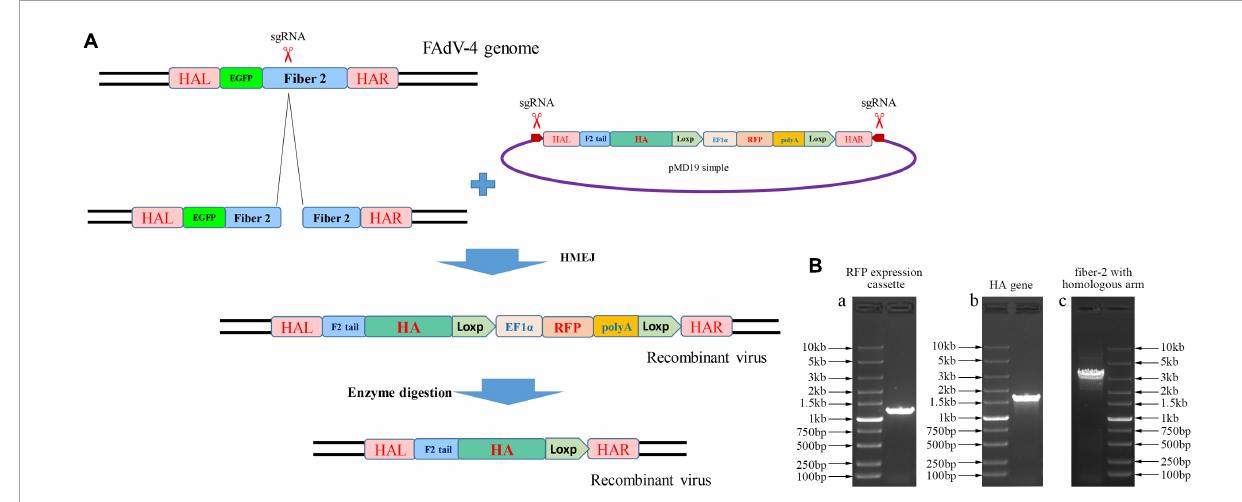
FIGURE1 Novel strategy for generating recombinant FAdV-4. (A) Schematic presentation for the construction of the recombinant FAdV-4. (B) Construction of the donor plasmid. PCR amplification of RFP expression cassette (a), HA gene of H9N2 (b), fiber-2 with left and right homologous arm